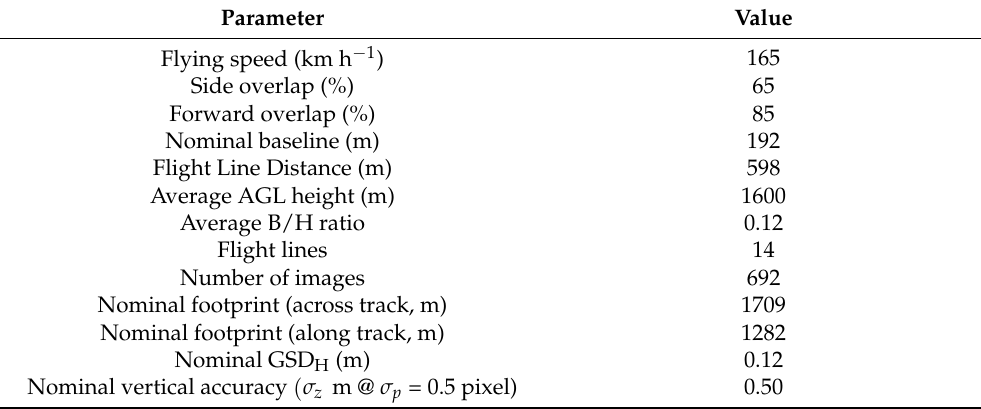
Table 1. Planned values of the main geometrical parameters for the operated flights.